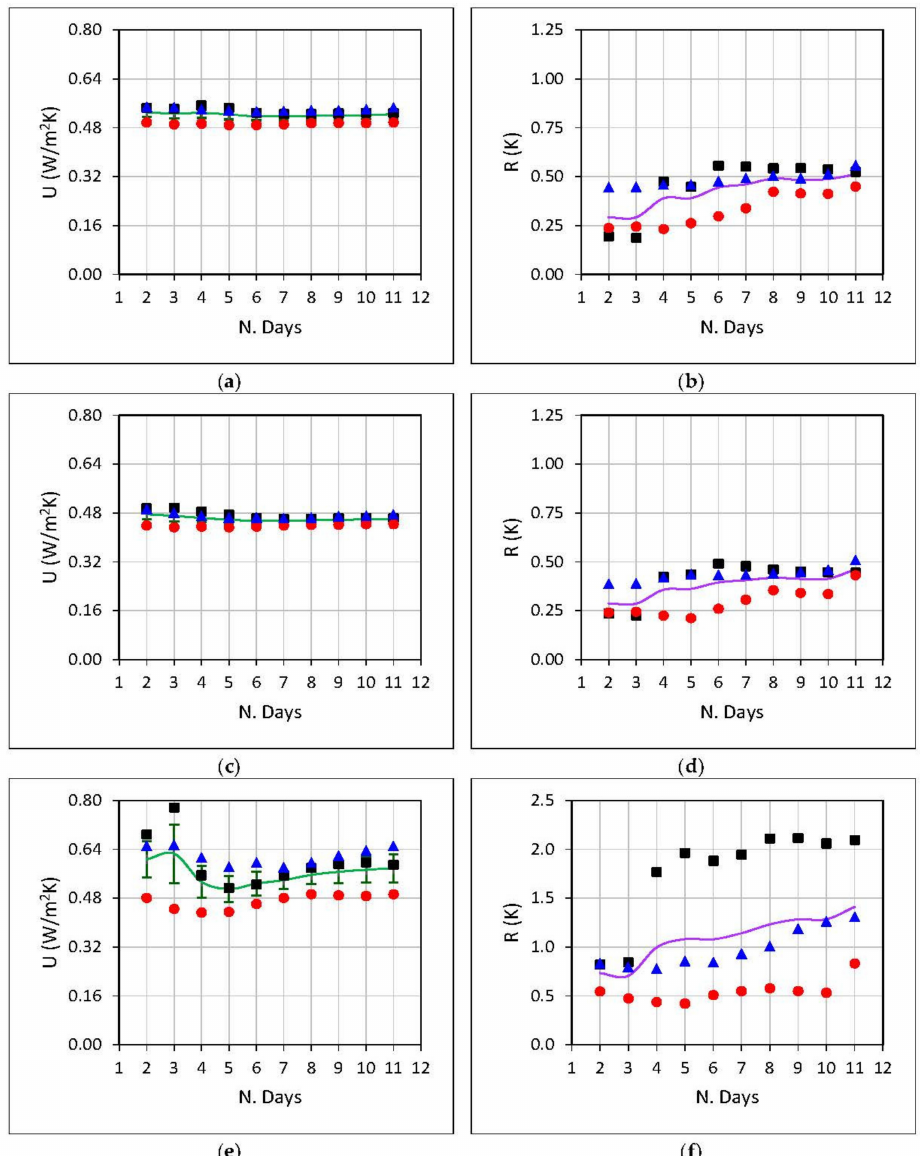
Figure 6. Opaque elements. Analysis of model performance for di ff erent length of test period. Series a in black, series b in red and series c in blue. The continuous lines represent the averages values from the results of the three data series a, b and c. Left U value. Right average of the residuals; ( a , b ) Ceiling; ( c , d ) Back wall; ( e , f )